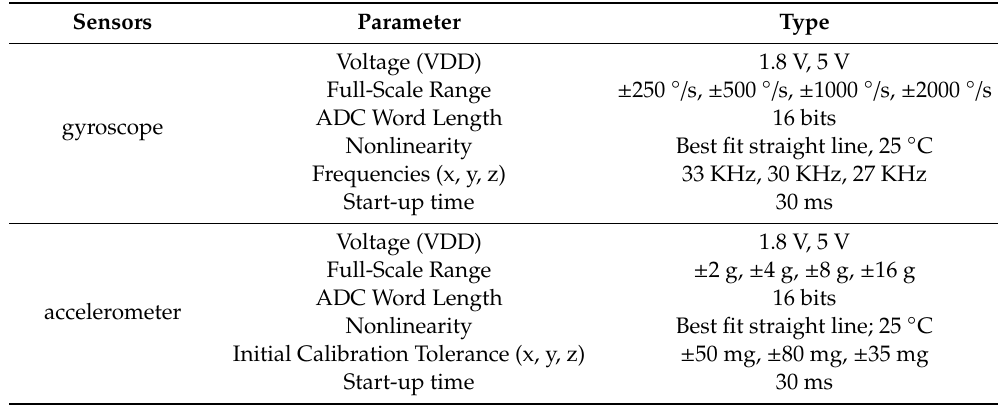
Figure 1. Illustration of the circuit design into the core of the ball. Table 3. Characteristics of the sensors in